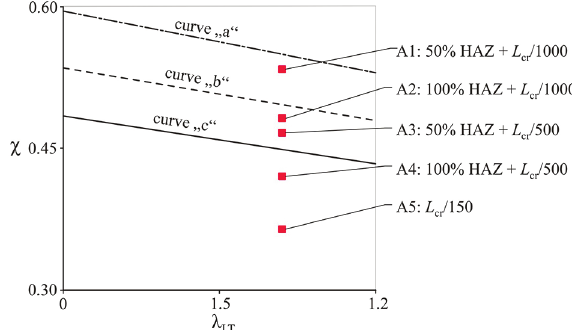
Fig. 17. comparison of numerical results with buckling curves